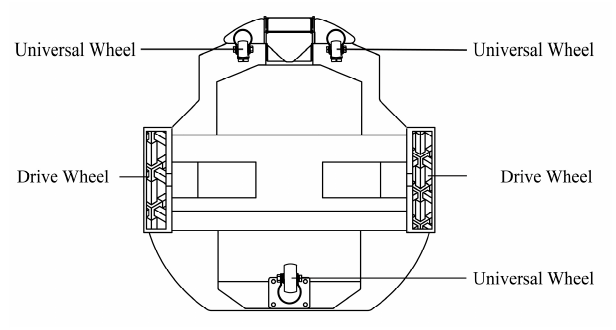
Figure 2. Chassis of cleaning robots.